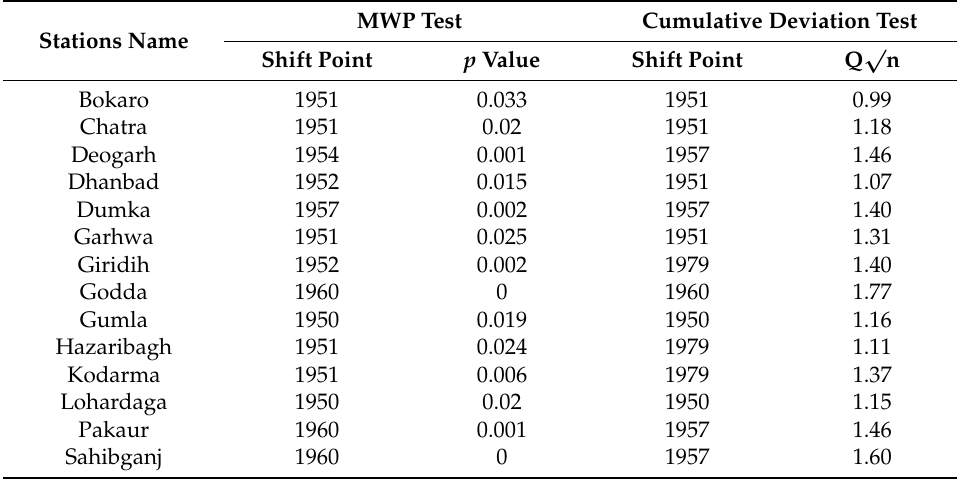
Table 3. Results of MWP test and Cumulative deviation